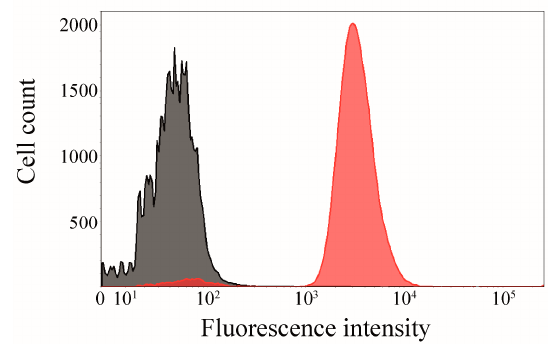
Figure 8. Proof of interaction between surface-displayed CK2 β and CK2 α -DBCO545-subunit. CK2 β , which was translocated on the surface of E. coli by Autodisplay, was incubated for 1 h at 37 °C with purified specifically labeled CK2 α -DBCO545. The binding affinity of CK2 β and CK2 α -DBCO545 (red, mF = 3800) was analyzed by flow cytometry. As a non-binding control, surface-displayed sorbitol dehydrogenase [33] was used (grey, mF = 108).